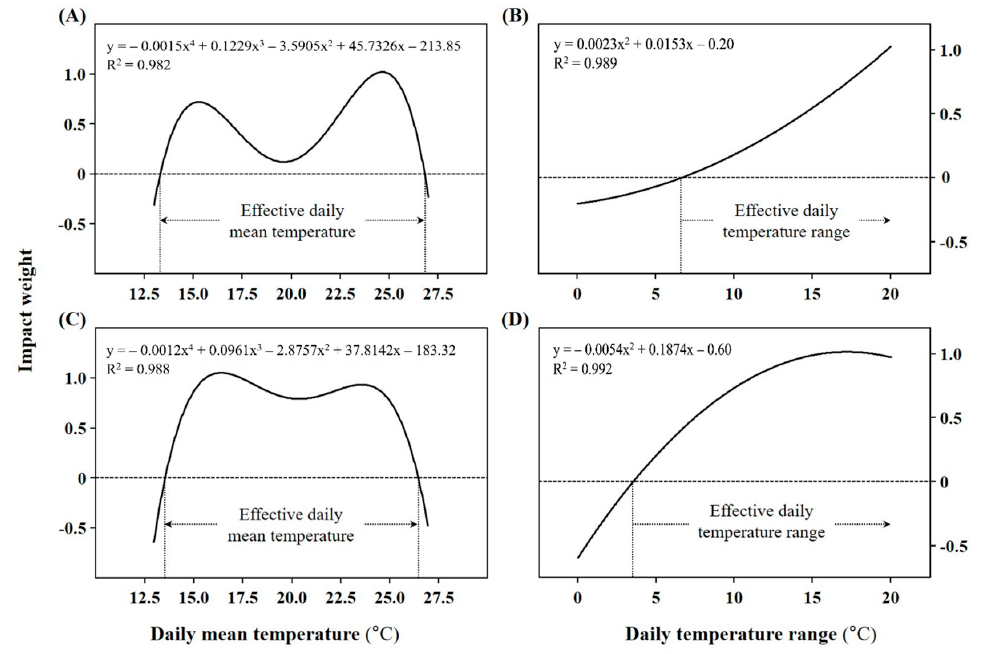
Figure 2. Regression curve of the impact weight on germination under two different temperature conditions of daily mean temperature and daily temperature range. Graphs in panels ( A , B ) show the results for Agastache rugosa and those in panels ( C , D ) show the results for Astilbe rubra . The curve was derived using the standardized regression coefficient ratios ( n = 160).